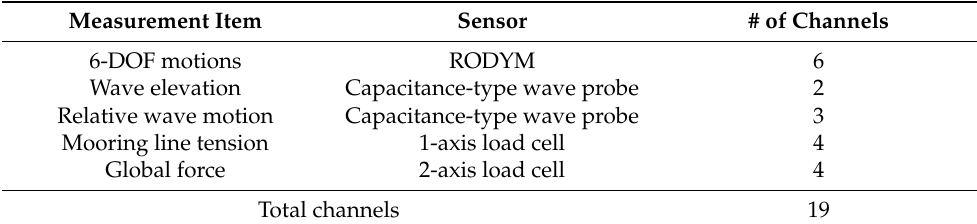
Table 3. Measuring items of model test.